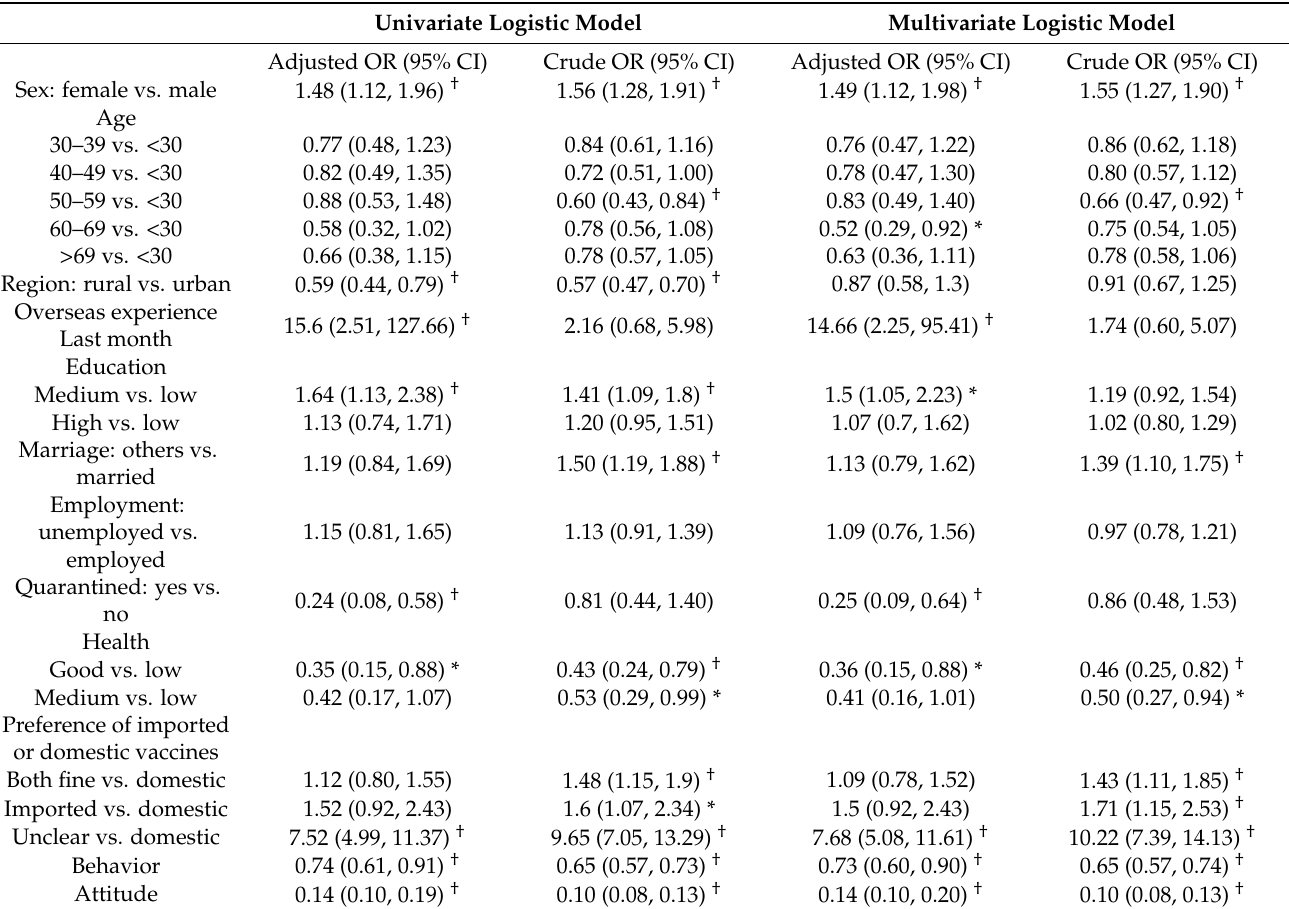
Table 2. Impact factors associated with COVID-19 vaccine acceptance. Univariate Logistic Model Multivariate Logistic